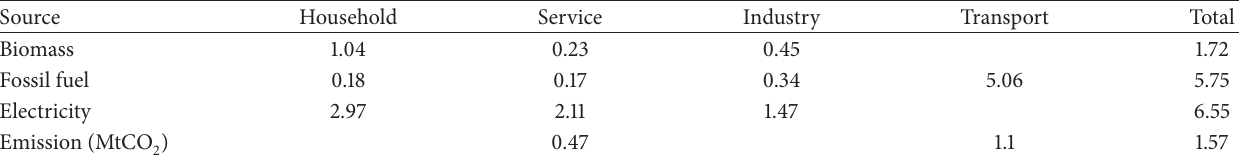
Table 1: Inland energy use by sector in 2009 (TWh)